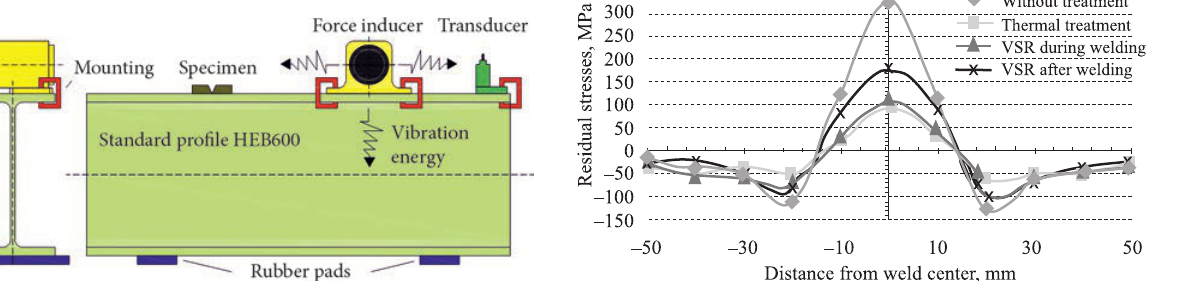
Fig. 2. Distribution of longitudinal residual stresses in specimens by ultrasonic technique